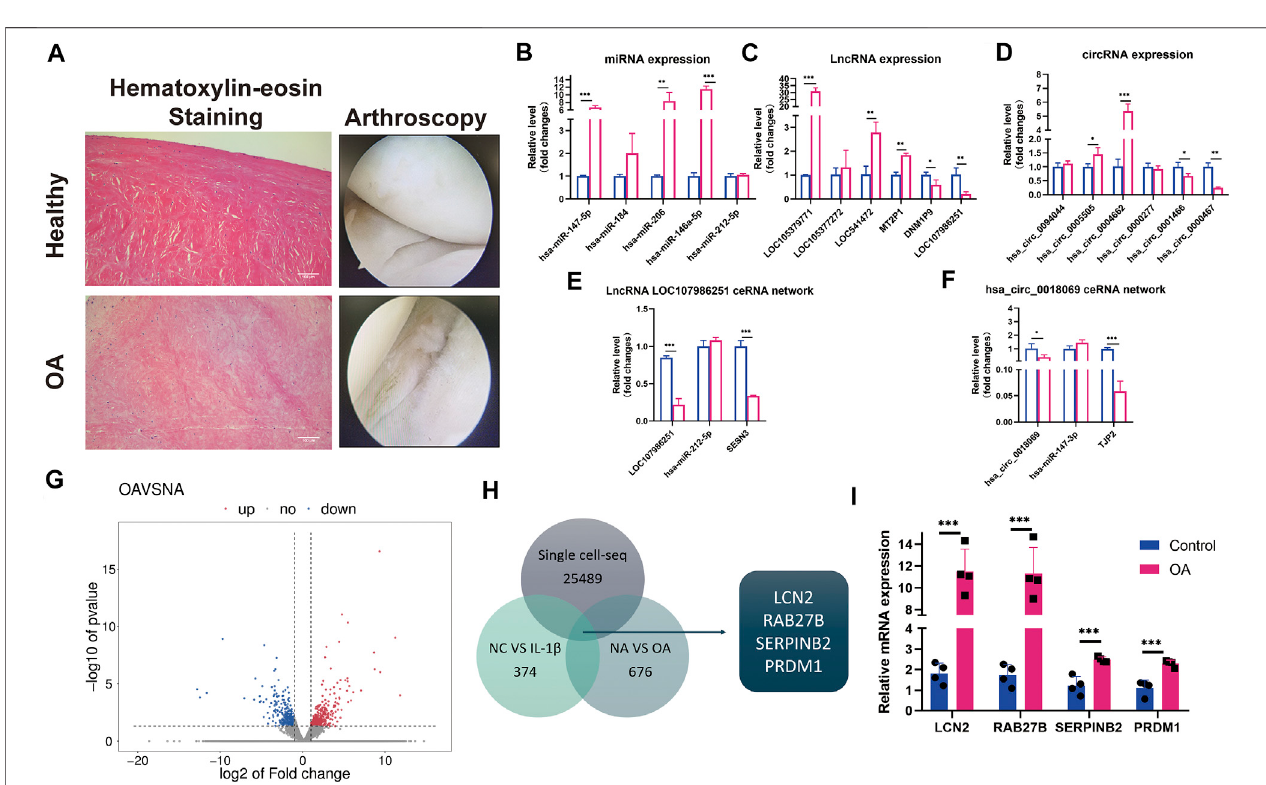
FIGURE 5 | qRT-PCR certi fi cation on control and degenerative meniscus and the selection of potential osteoarthritis (OA) biomarkers in meniscus. (A) Hematoxylin – eosin staining and arthroscopy of the meniscus from normal and degenerative OA meniscus. (B) Relative expression levels of selected differentially expressed microRNAs (DEMs) in normal versus degenerative meniscus. U6 was used as the internal reference gene for qRT-PCR relative expression. Error bars reveal the standard deviation or the standard error of the data. The statistical methods are described above. * p < 0.05, ** p < 0.01, *** p < 0.001. (C) Relative expression levelsofselecteddifferentiallyexpressedcircRNA(DECs)innormalversusdegenerativemeniscus.GAPDHwasusedastheinternalreferencegeneforqRT-PCRrelative expression.Errorbarsrevealthestandarddeviationorthestandarderrorofthedata.Thestatisticalmethodsaredescribedabove.* p < 0.05,** p < 0.01,*** p < 0.001. (D) Relative expression levels ofselected differentially expressed lncRNAs (DELs) in normal versus degenerative meniscus. GAPDH was used as the internal reference gene for qRT-PCRrelativeexpression. Errorbars reveal thestandard deviation or thestandarderror ofthe data. The statistical methods aredescribedabove. * p < 0.05, ** p < 0.01, *** p < 0.001. (E) Relative expression patterns of lncRNA LOC107986251hsa_circ_0018069 in normal versus degenerative meniscus. GAPDH was used as the internalreferencegenefor qRT-PCRrelative expression. Errorbars reveal thestandarddeviationor thestandarderror ofthedata.The statistical methods aredescribed above. * p < 0.05, ** p < 0.01, *** p < 0.001. (F) Relative expression patterns of hsa_circ_0018069 in normal versus degenerative meniscus. GAPDH was used as the internalreferencegenefor qRT-PCRrelative expression. Errorbars reveal thestandarddeviationor thestandarderror ofthedata.The statistical methods aredescribed above. * p < 0.05, ** p < 0.01, *** p < 0.001. (G) The scatter plots of differentially expressed mRNAs between normal and degenerative menisci. (H) The Venn diagram of single-cell sequence data of normal meniscus versus degenerative meniscus, whole-transcriptome sequence data of control versus IL-1 β stimulated OA